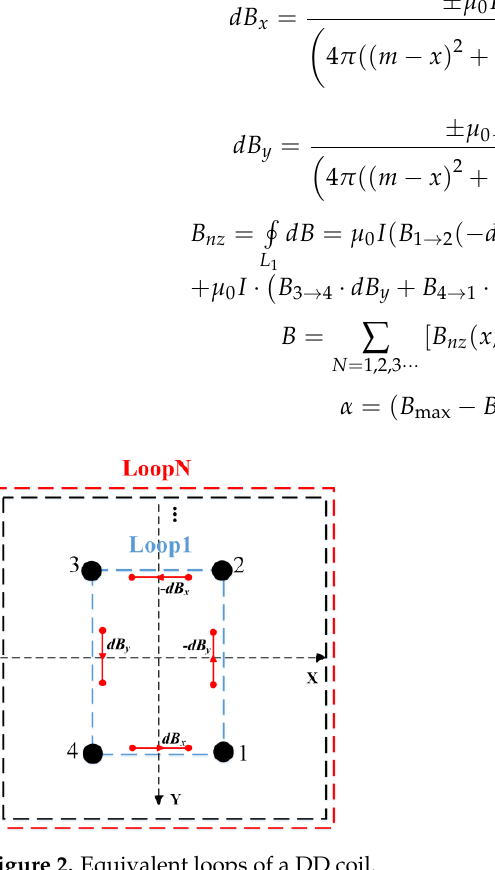
Figure 2. Equivalent loops of a DD coil.